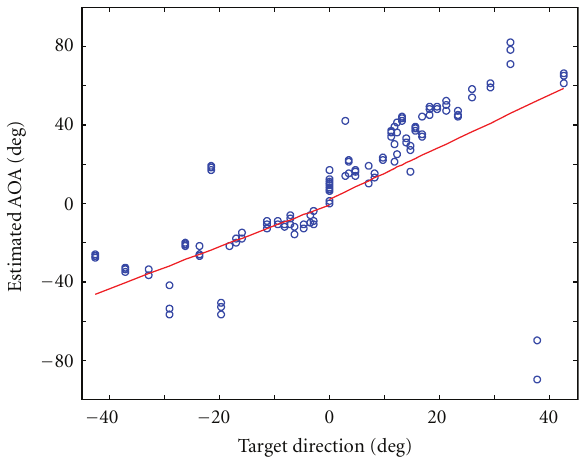
Figure 12: Estimated AOA by MUSIC derived from the measure- ments in outdoor experiments.